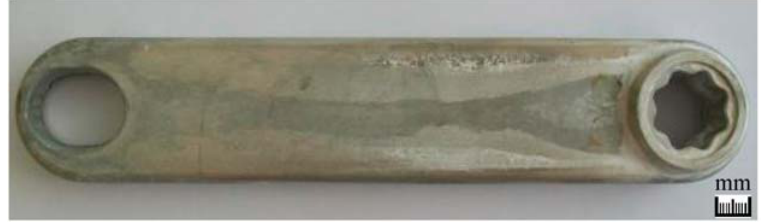
Figure 17. Rod made by magnesium HPDC with the internal core of aluminium foam.